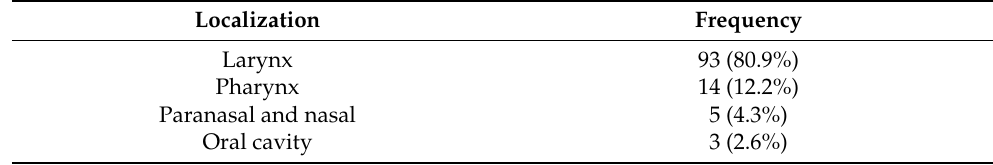
Table 1. Frequency of head and neck cancer localization in our